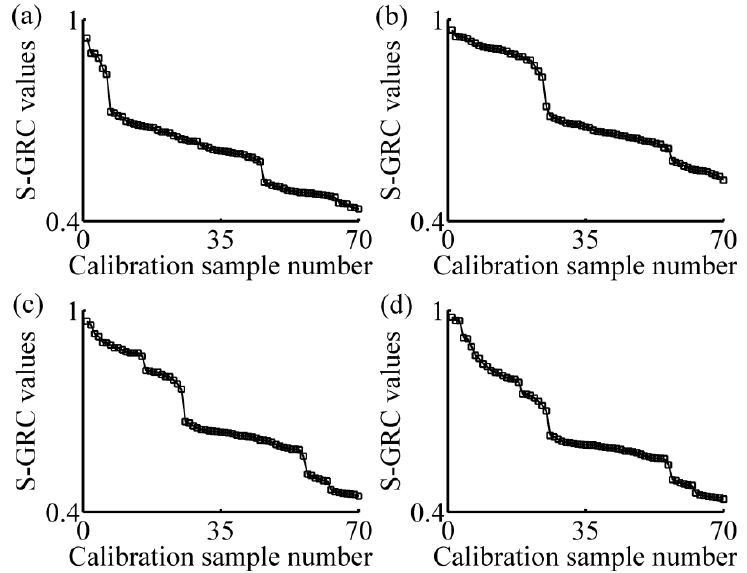
Figure 2. Variation of the S-GRC with the number of calibration samples. ( a ) two-component sample 1